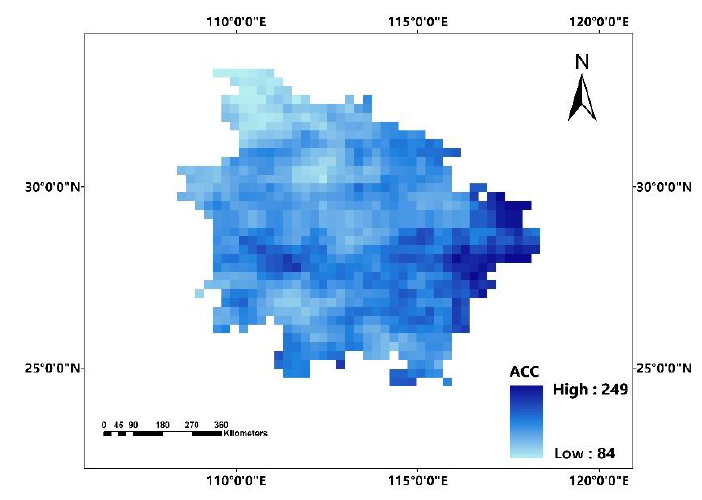
Figure 12. Mean annual maximum of three-day accumulated precipitation.